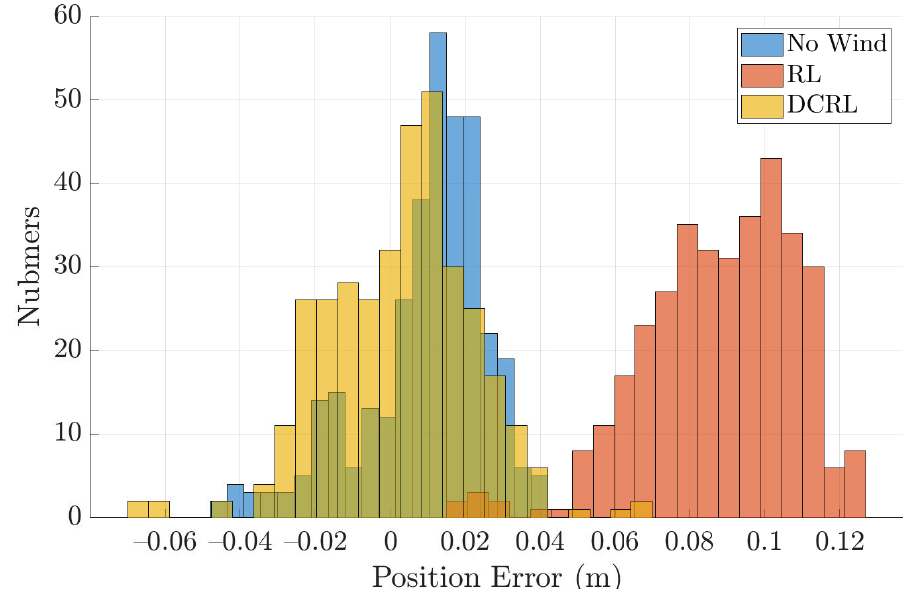
Figure 5. The position error histogram distribution of indoor fix-position hover experiment. The mean error of the original RL controller and the disturbance compensation RL (DCRL) is 8.4 cm and is 2 cm